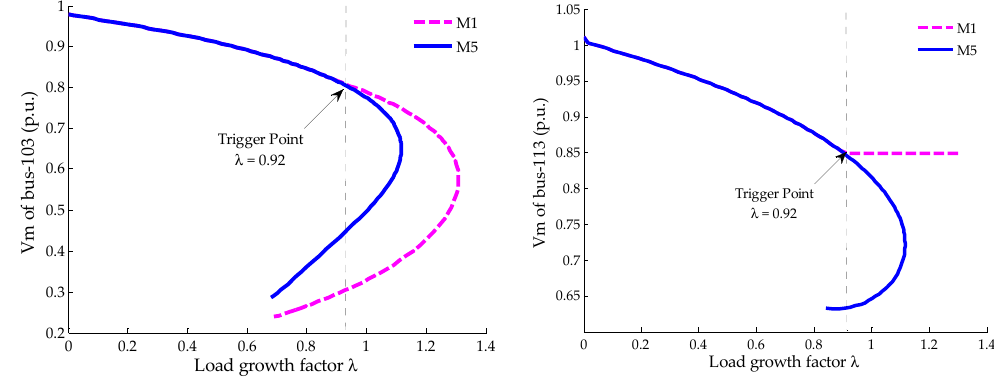
Figure 9. The V– λ curves under schemes M1 and M5.